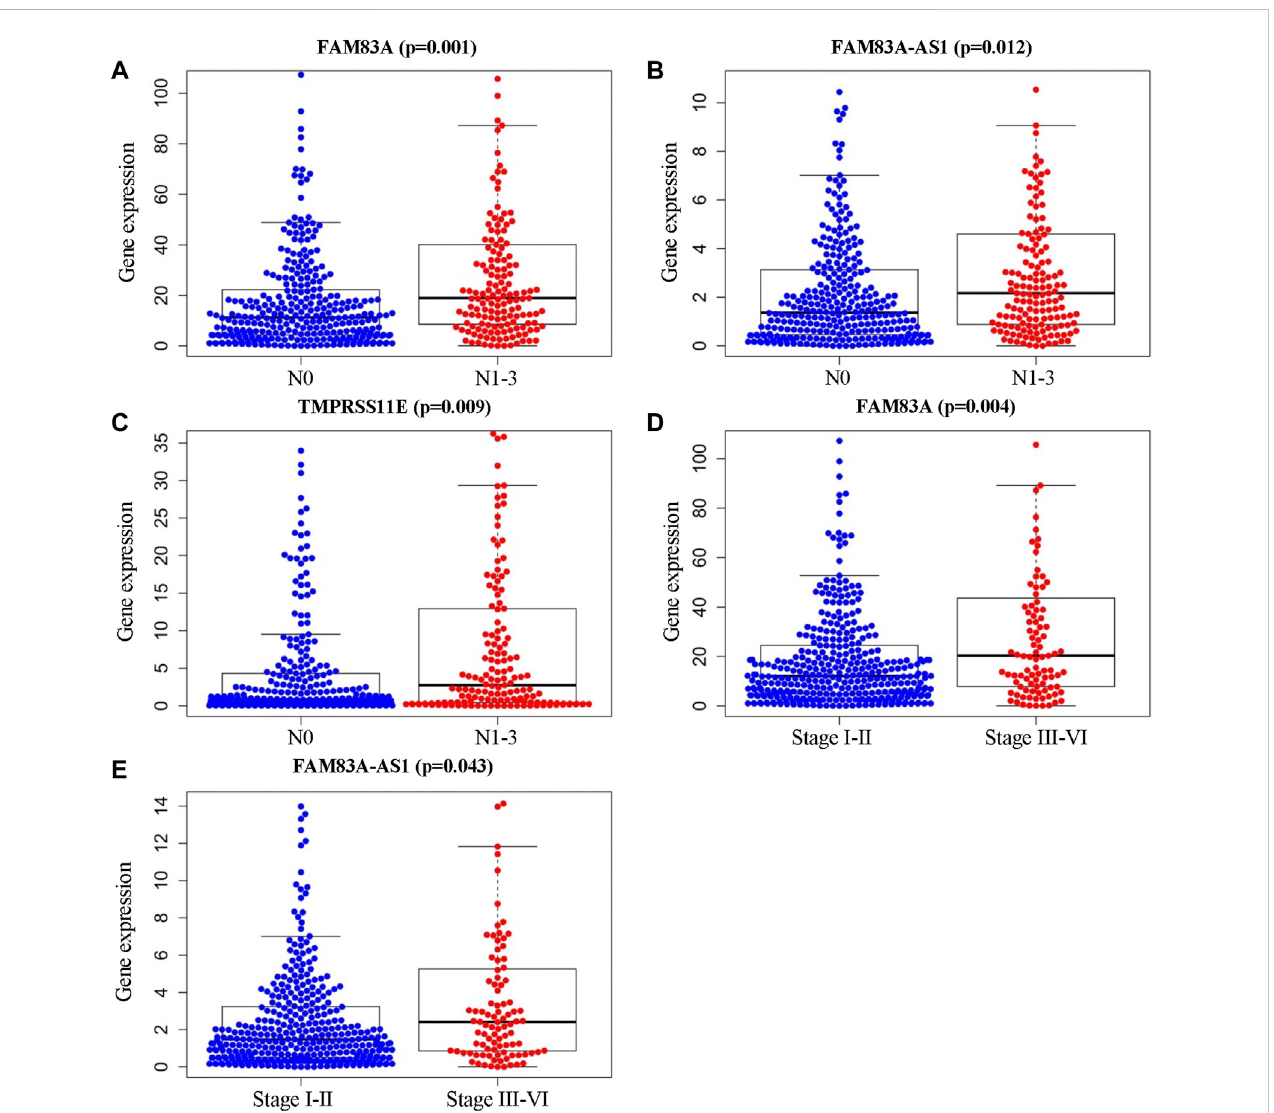
FIGURE 4 Clinical characteristic analysisofEMT-LUAD related genes withindependent signi fi cantprognostic value. (A – C) Association of geneexpressionlevels of FAM83A, FAM83A-AS1, and TMPRSS11E with the number of lymph node metastasis. (D, E) Association of FAM83A, and FAM83A-AS1 expressions with tumor stages and metastasis in LUAD